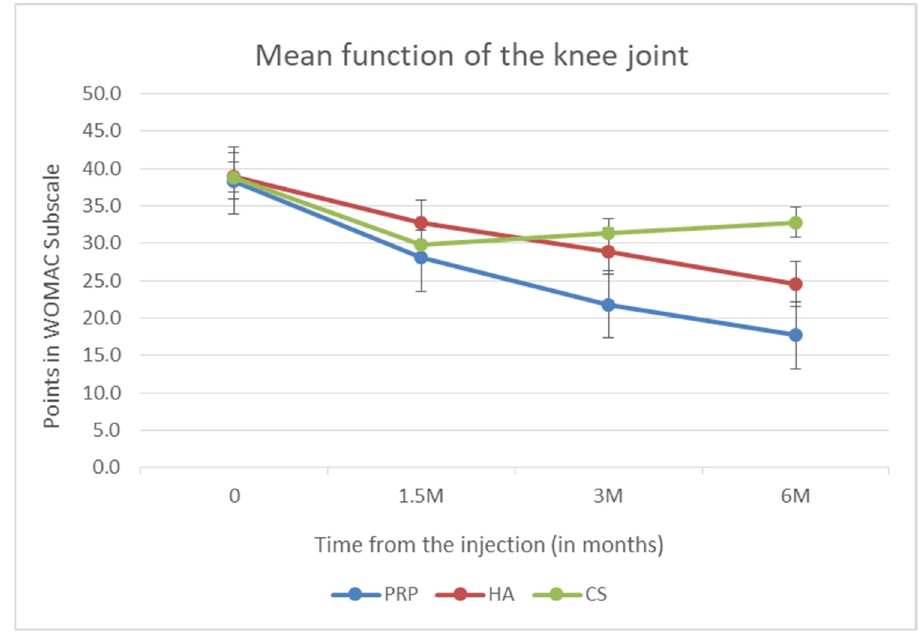
Figure 4. Mean function of the knee joint (points in WOMAC subscale).